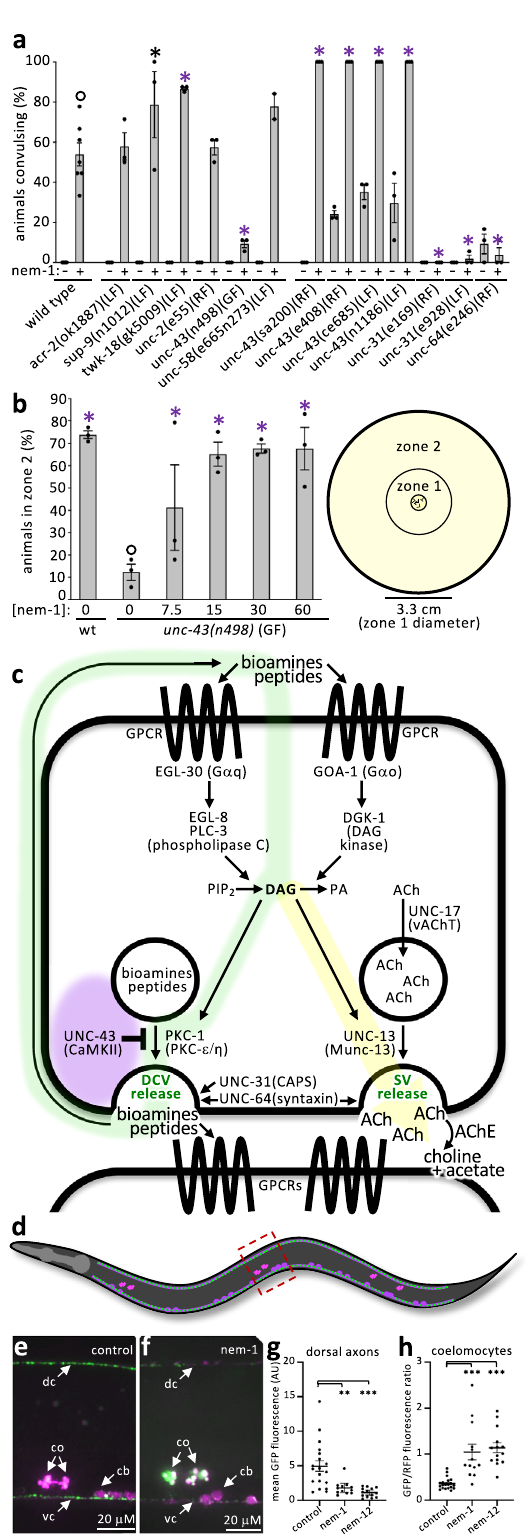
(and unc-31 and unc-64 RF mutants) remain sensitive to the lethal effects of nementin-1 (Supplementary Fig. 4; Supplementary Data 4). Together, these data argue against the idea that UNC-43 is nementin-1 ’ s sole physiologically relevant target. Instead, the similarities between nementin-1-induced phenotypes and the unc- 43 RF mutants suggest that the compound targets a component(s) that acts with UNC-43 (Fig. 4c, purple glow).